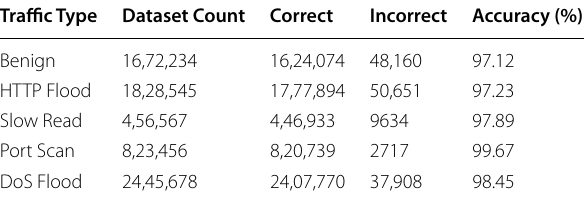
Traffic Type Dataset Count Correct